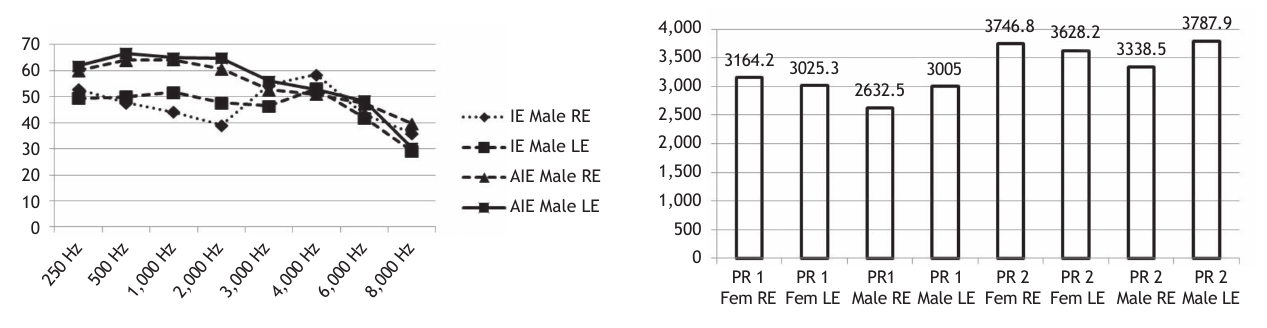
Figure 5 Sound pressure level with the two types of ear phones and in both ears in male gender. IE, insertion earphone; AIE, anatomic insertion earphone; RE, right ear; LE, left ear.